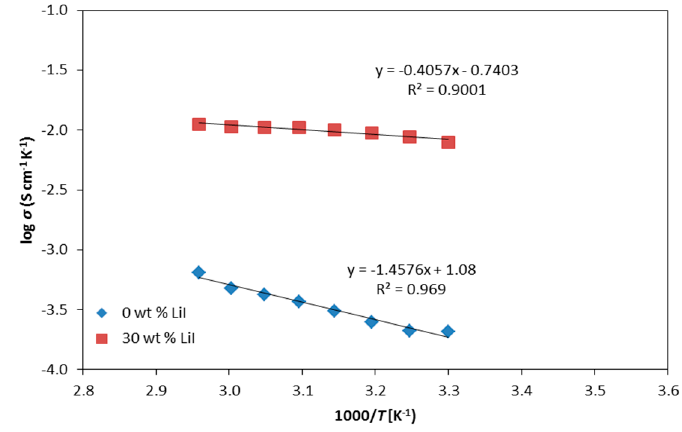
Figure 5. Arrhenius plots for CMKC/CMCE-LiI films.